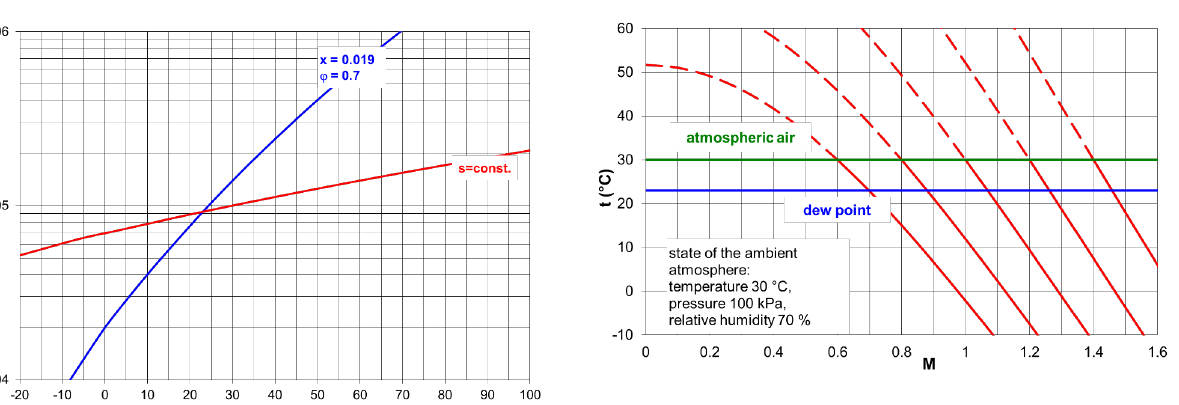
Fig. 6. Dependence of the moist air temperature t upon the air- craft Mach number M assuming isentropic flow conditions (red lines)